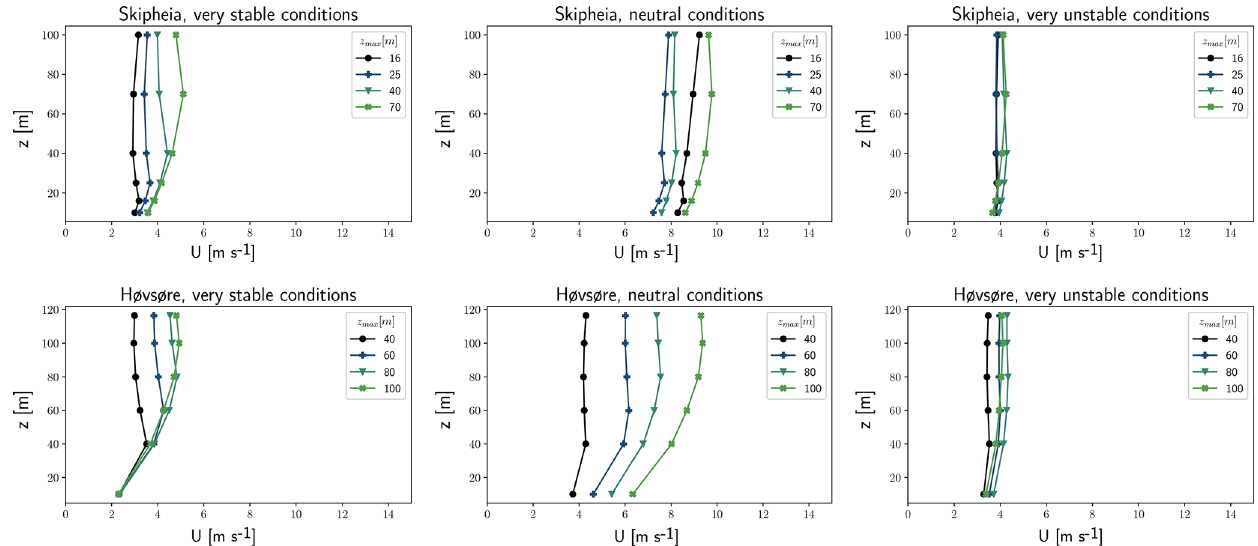
Figure 11. Mean velocity profiles at Skipheia and Høvsøre with maximum at different heights, during very stable, neutral and very unstable atmospheric